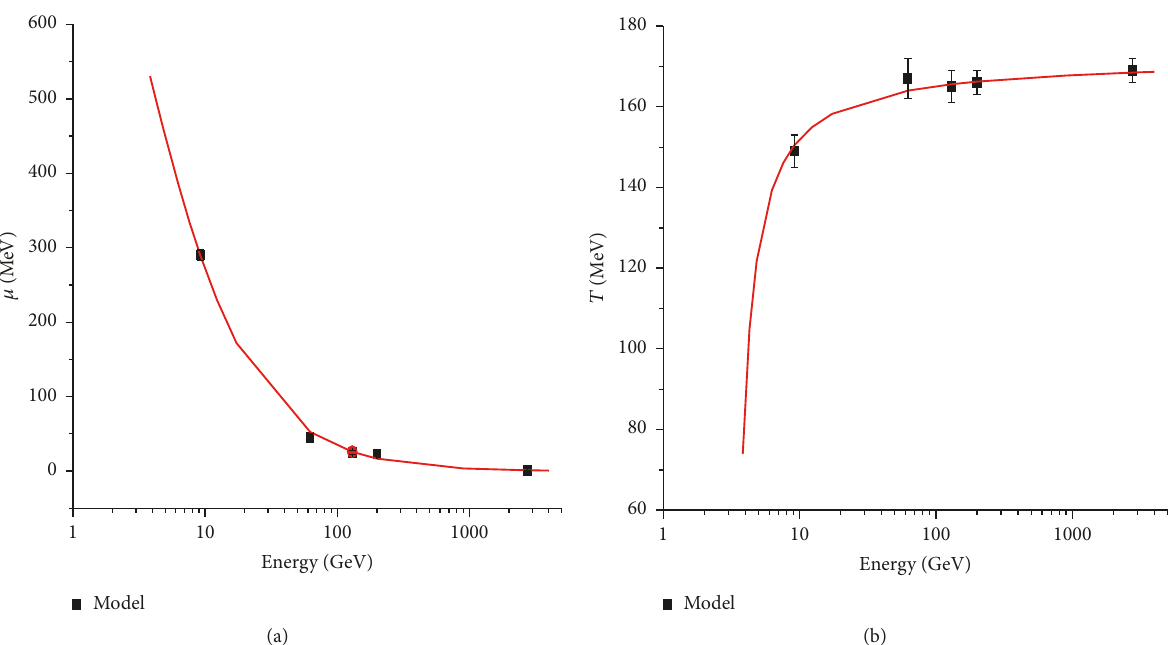
Figure 1: The energy dependence of baryon chemical potential (a) and chemical freeze-out temperature (b) in our model.